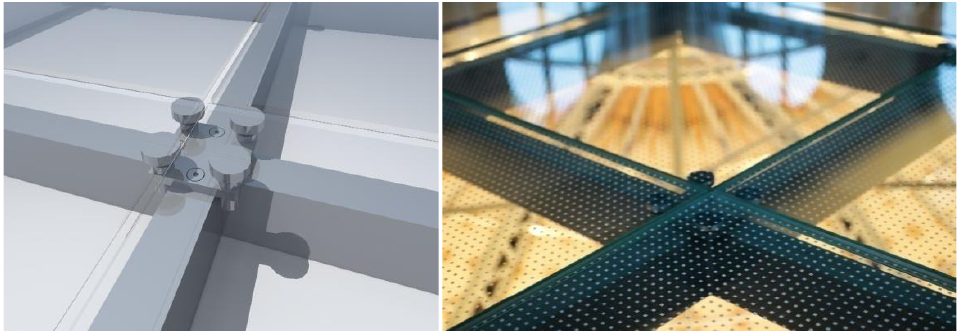
Fig. 2 a, b Additionally assembled targets for point supporting of the glass floor.